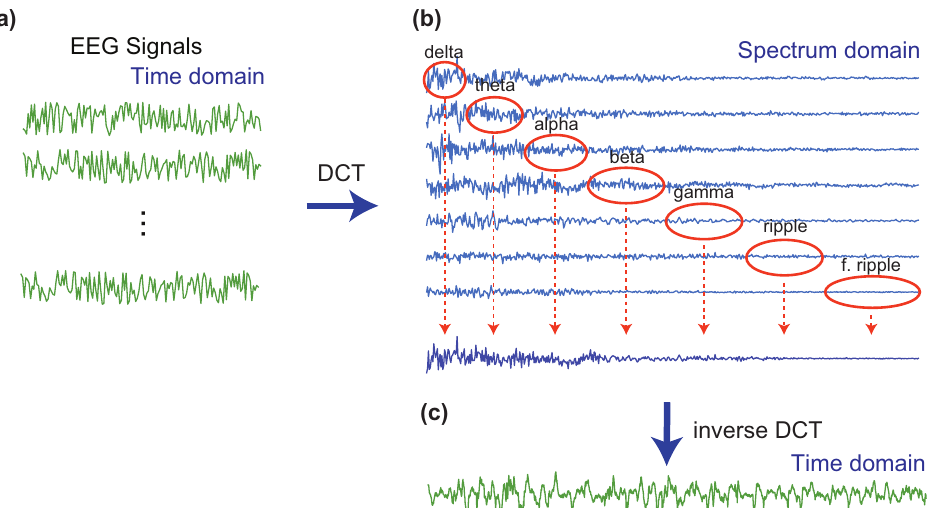
Figure 4. An artificial signal generation with the DCT. ( a ) Seven intracranial iEEG signals at either focal or non-focal area. ( b ) DCT coefficients in the spectrum-domain. The spectra are segmented into seven physiological sub-bands, and the sub-band components extracted from each spectrum are merged to create an artificial spectrum. ( c ) The inverse DCT leads to the resulting artificial